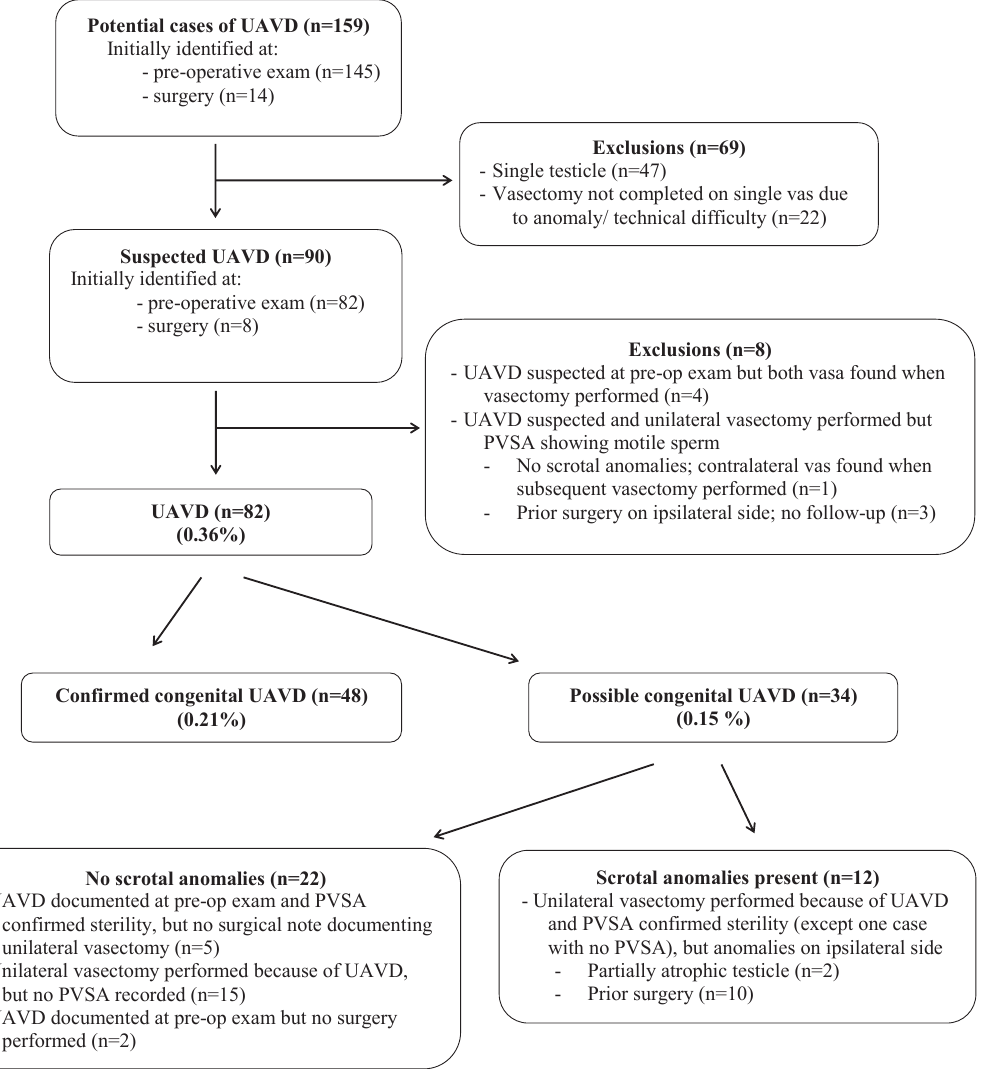
Figure 1 - Flow chart of identification and classification of cases of unilateral absence of vas in men seeking vasectomy